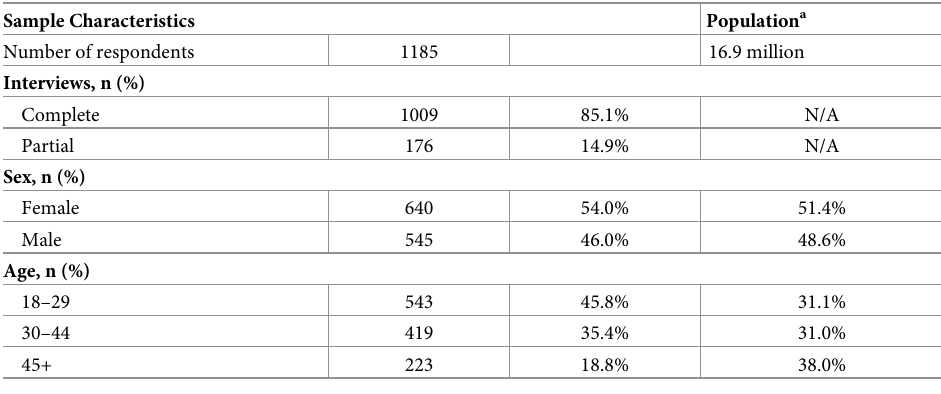
Table 3. Respondent demographics: Ecuador COVID-19 MPS.